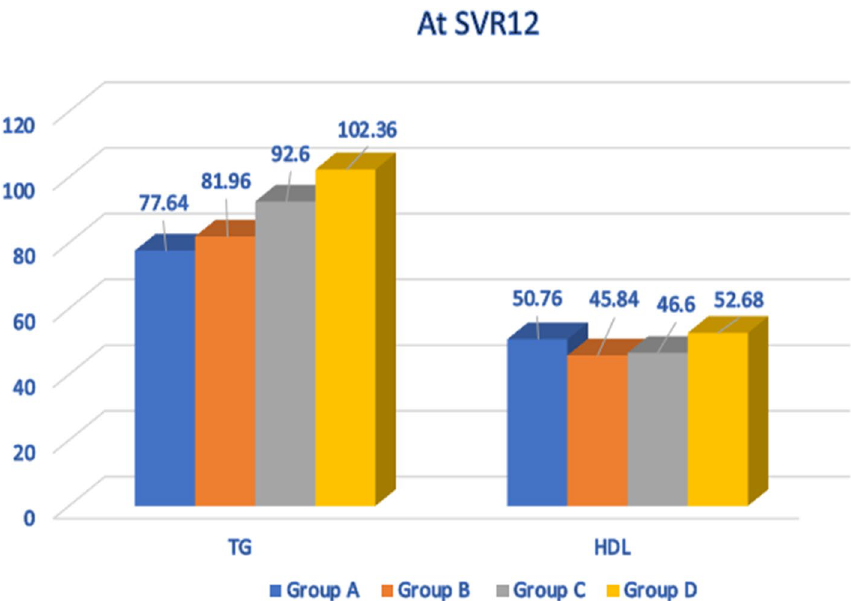
Fig. 2 Comparison between all the patients in this study regarding the lipid profile before treatment and at